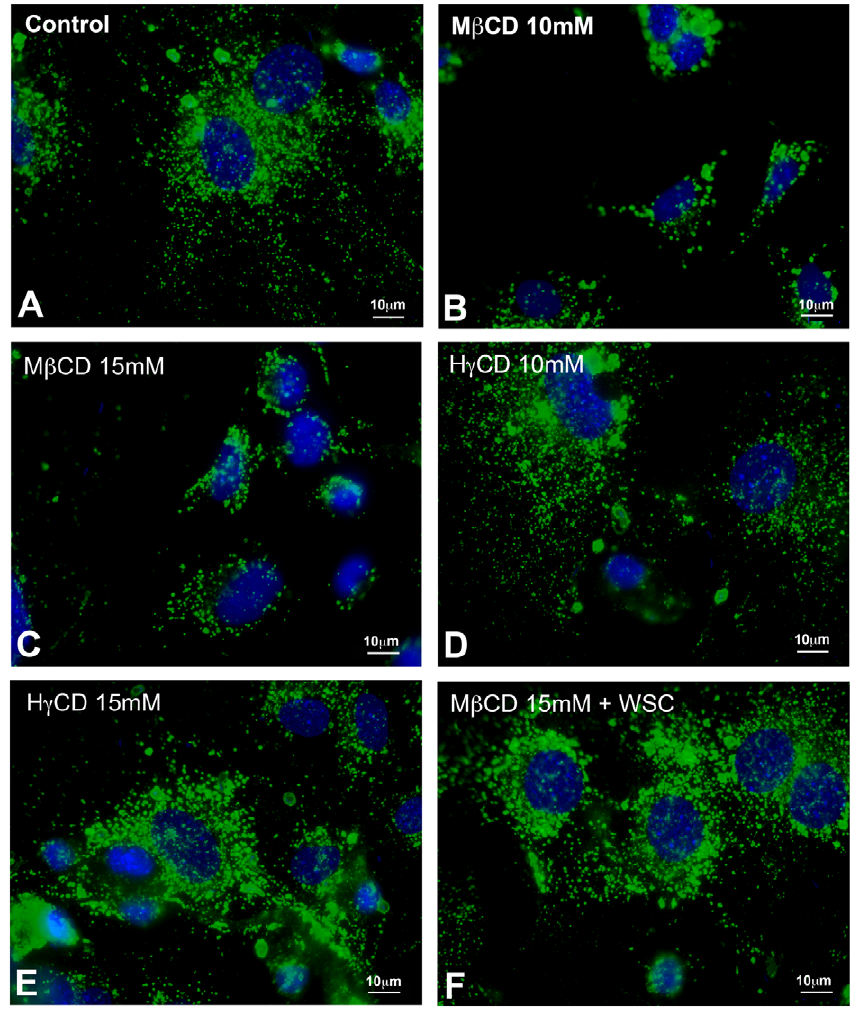
Figure 6. Cholesterol depletion leads to changes in lysosomal distribution within cells. Representative panels of lysosomal distribution in control cardiomyocyte (A) and cardiomyocytes pre-treated either with 10 mM (B) or 15 mM M b CD (C), 10 mM or (D) 15 mM H c CD (E), or 15 mM M b CD followed by 0.05 mM WSC (F). M b CD treated cardiomyocytes show significant changes in lysosomal dispersion in cell cytoplasm. After drug treatment, cells were washed and incubated with T. cruzi TCTs, M.O.I. of 50 parasites per cell for 40 minutes at 37 u C. After cell invasion, cells were washed, fixed and immunostained for LAMP-1 (green) DAPI (blue) and analyzed under fluorescence microscope. In comparison to untreated cardiomyocytes (A), which exhibit homogenous and well distributed LAMP-1 labeling, M b CD treated cardiomyocytes, (B) and (C), show a heterogeneous LAMP-1 labeling with lysosomes localized predominantly near cell nuclei. On the other hand, H c CD treated cardiomyocytes and cholesterol-replenished cells, (E), (F) and (D), present lysosomal distribution similar to control cells. Scale bar: 10 m